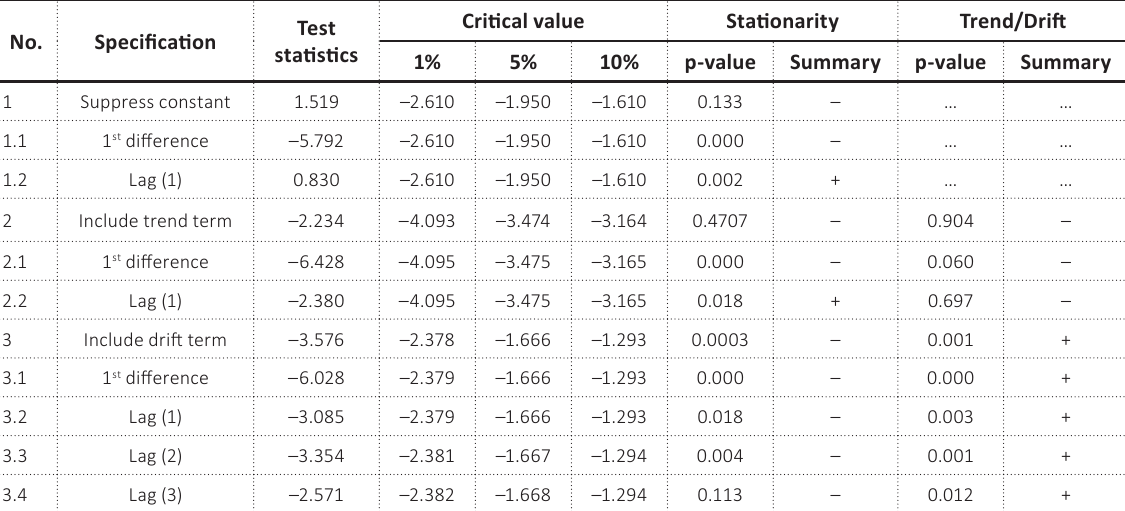
Table 1. Dickey-Fuller test for unit root (USD/UAH official exchange rate)